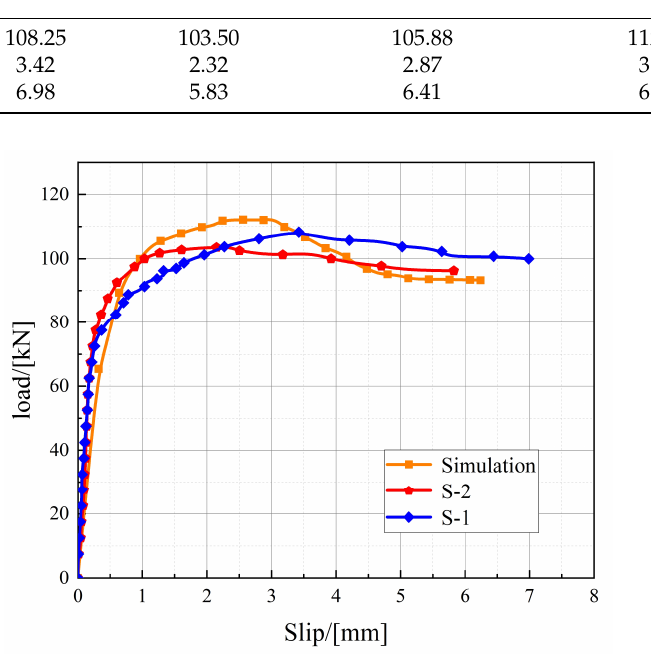
Figure 18. Comparison between the simulated and experimental load-slip curves.